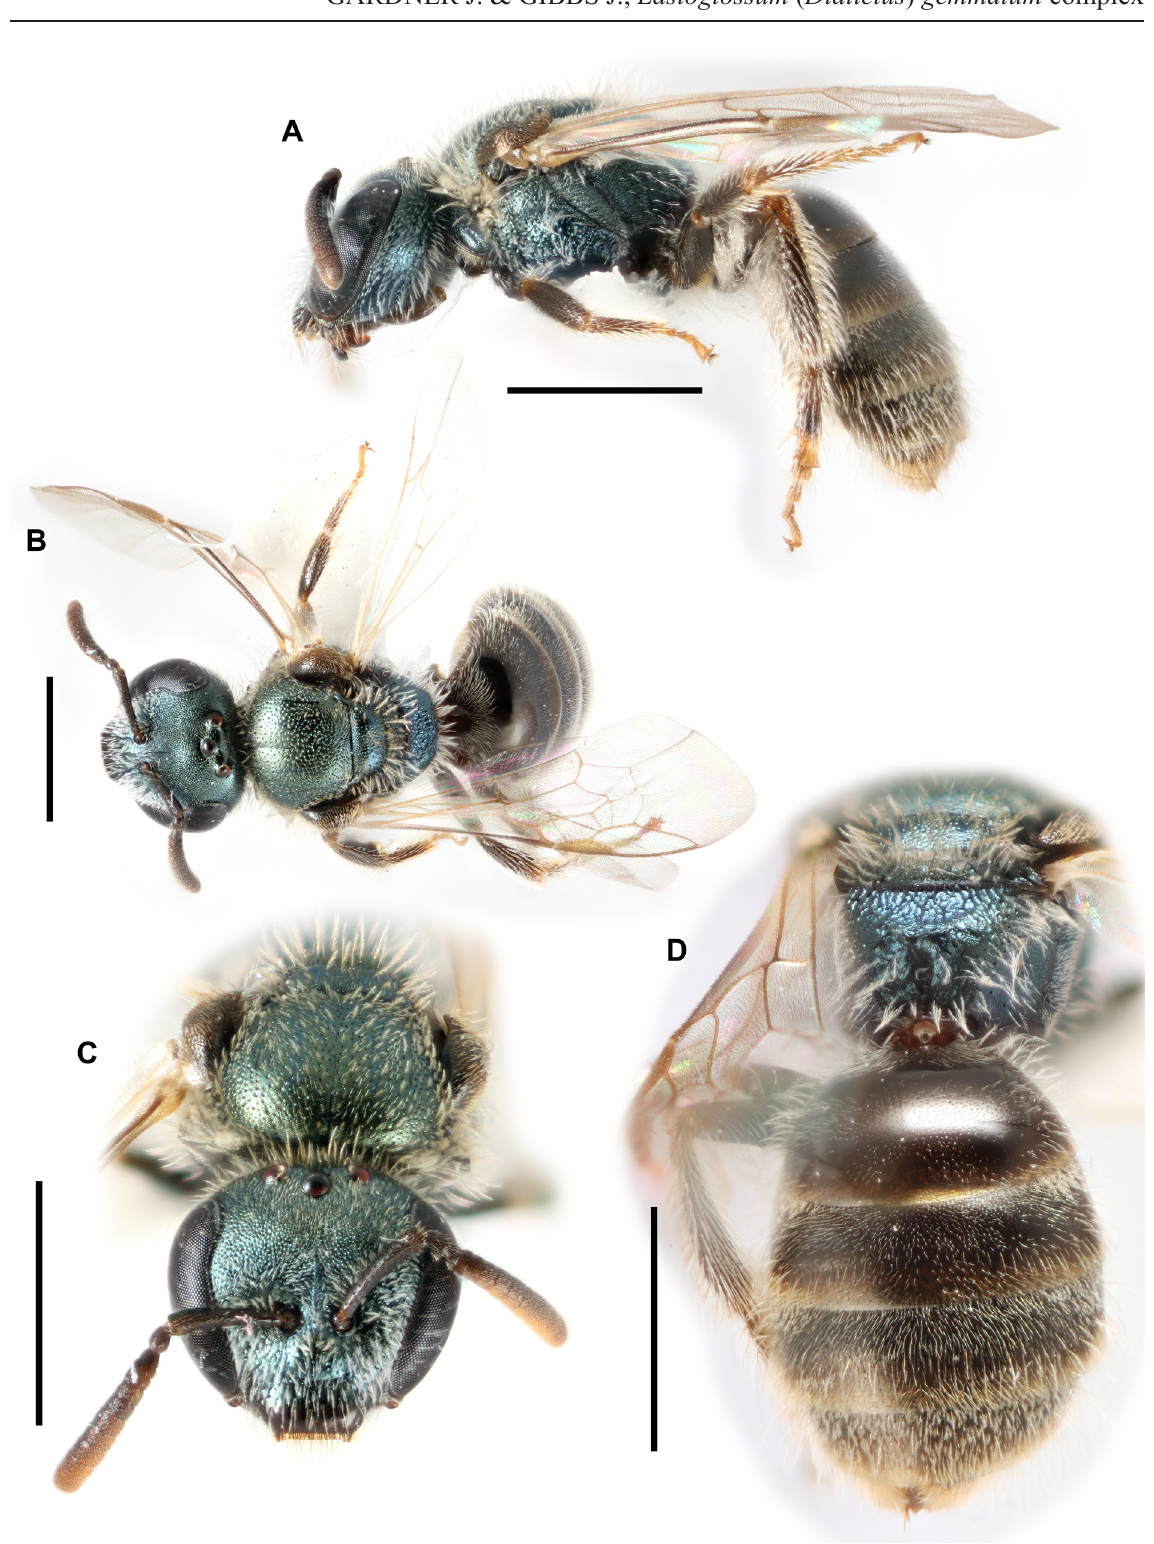
Fig. 3. Lasioglossum ( D .) angelicum sp. nov., ♀, holotype (LACM ENT 376858). A . Lateral habitus. B . Dorsal habitus. C . Face. D . Metasoma and propodeum. Scale bars = 1